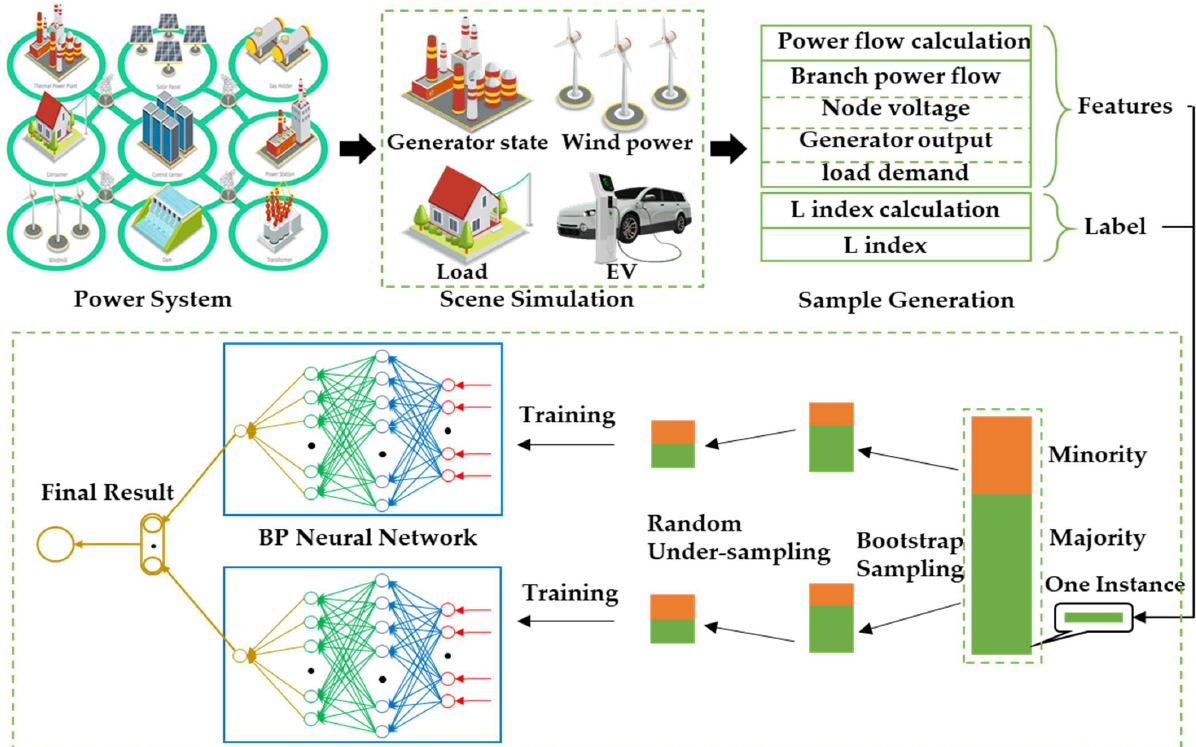
Figure 4. The framework for static VSA of power system based on RUSBagging.